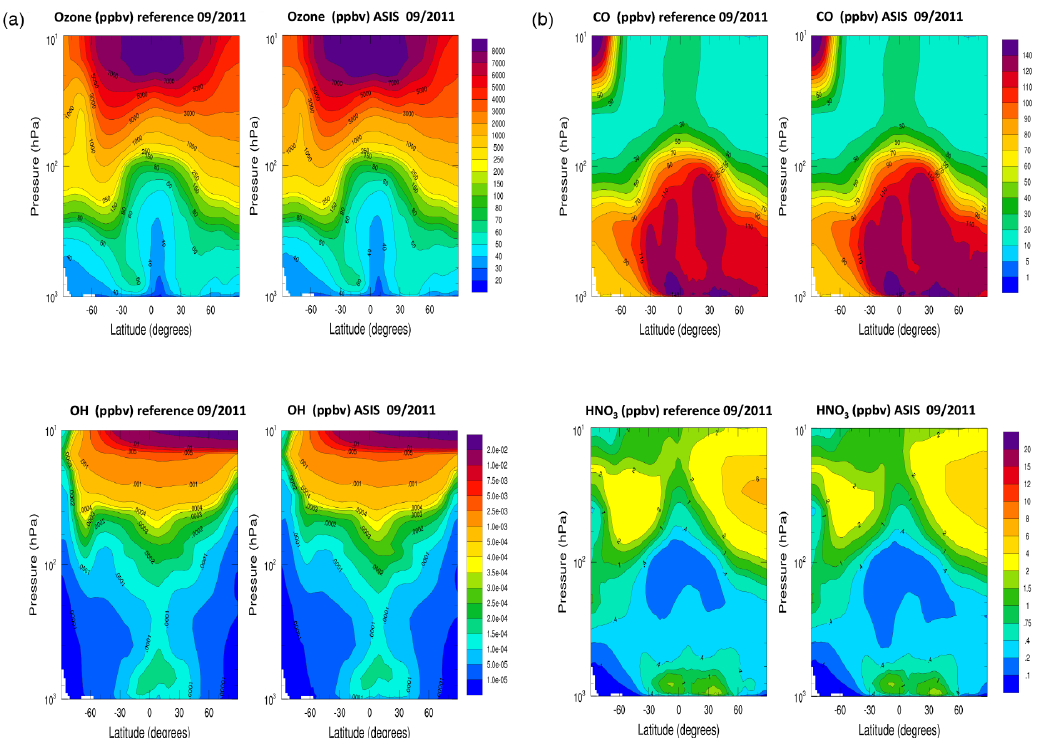
Figure 6. Zonal mean distributions of O 3 , CO , OH, and HNO 3 for the month of September. The panels in (a) show results for the reference simulation, MR; those in (b) show results of the MA simulation with the use of the ASIS solver.